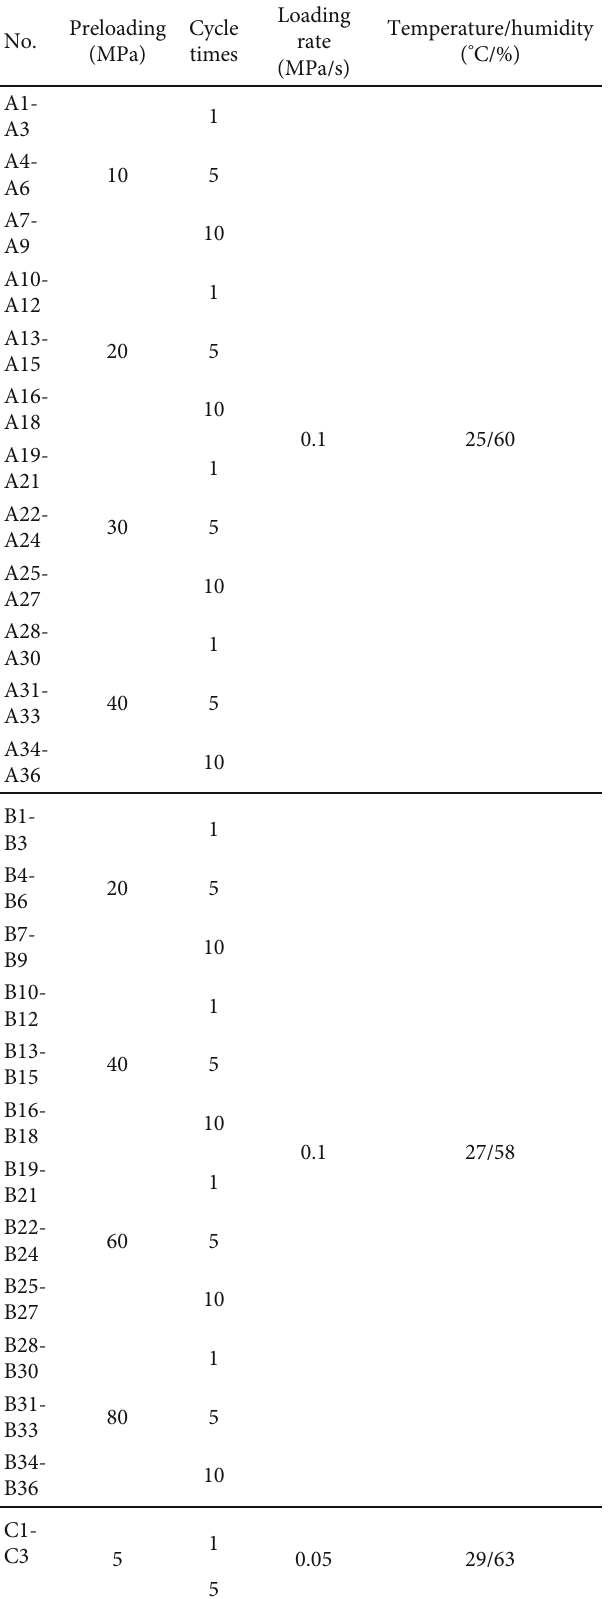
Table 2: Loading parameters and environmental parameters. Table 2: